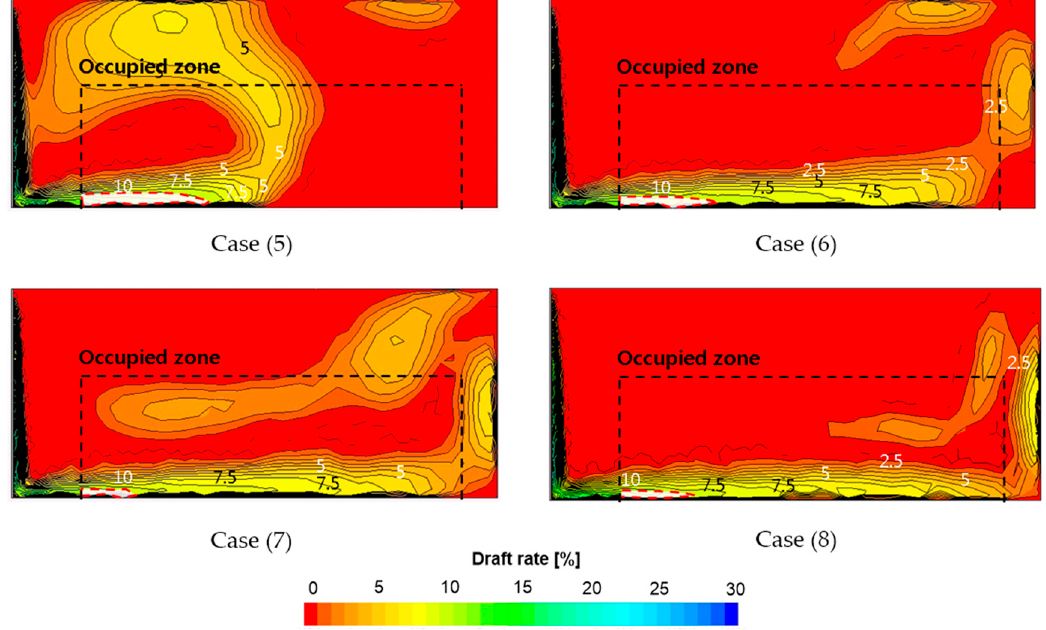
Figure 15. Draft rate distribution.